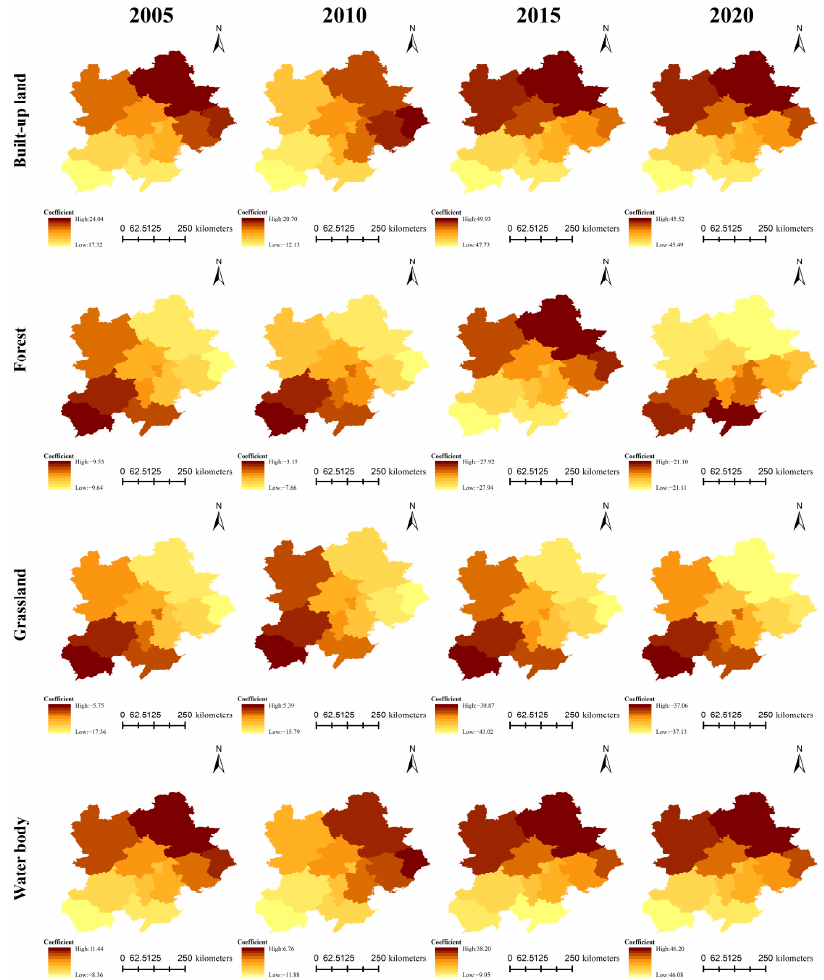
Figure 8. Coefficient between UTCI and LUCC types in BTH.